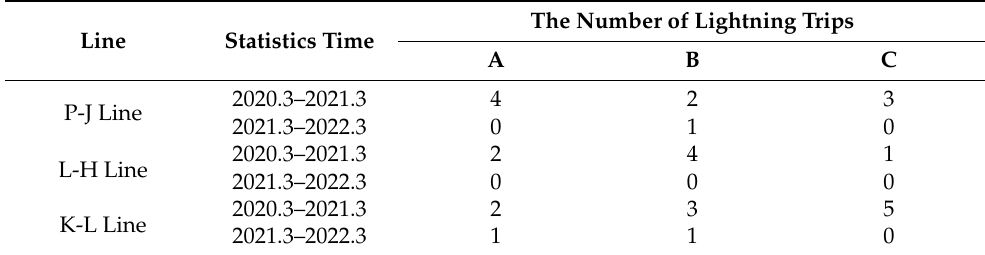
Table 3. Statistics on the number of lightning trips before and after installation. The Number of Lightning Line Statistics Time